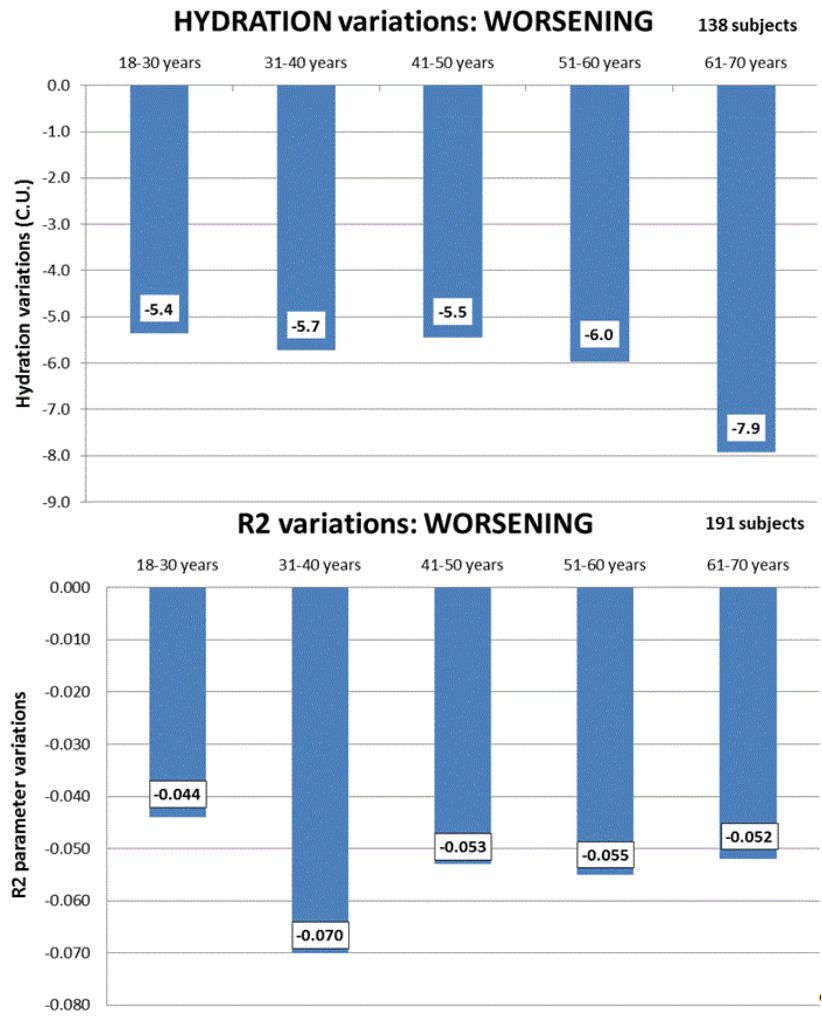
Figure 8. Worsening of skin hydration, elasticity and roughness values at the end of cosmetic treatments as a function of the age group. Statistical comparison among the age groups: p > 0.05 (non-significant) for all the considered